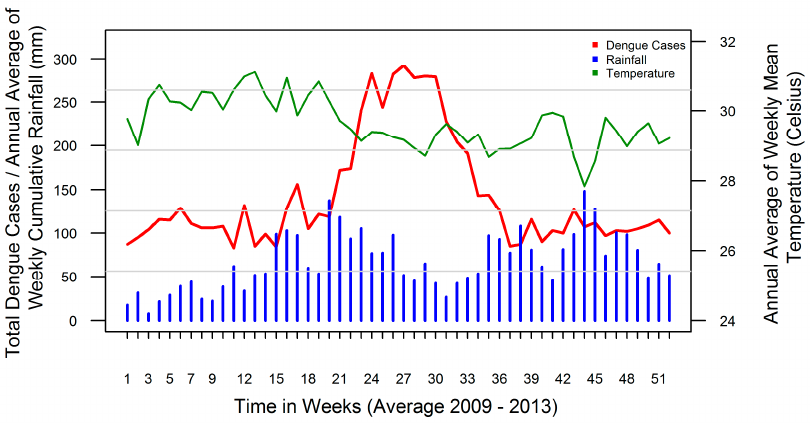
Figure 4. Week specific cumulative dengue cases, average rainfall and average temperature